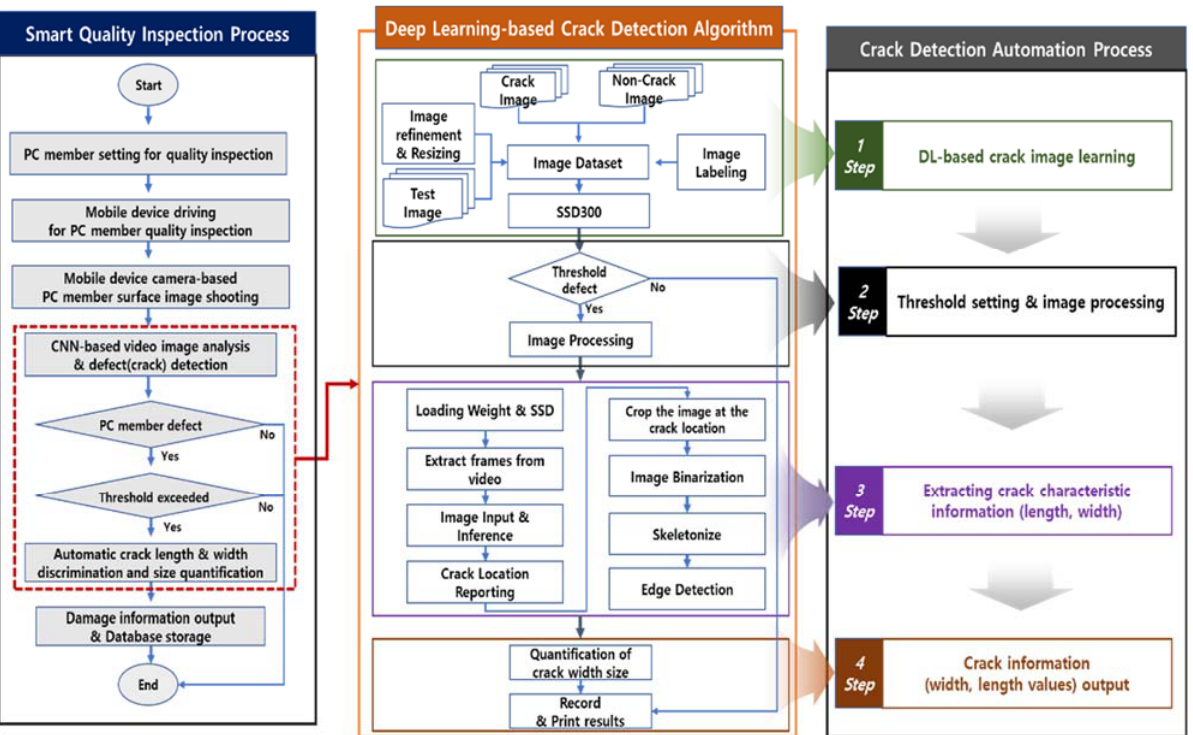
Figure 8. Deep learning ‐ based smart quality inspection process.